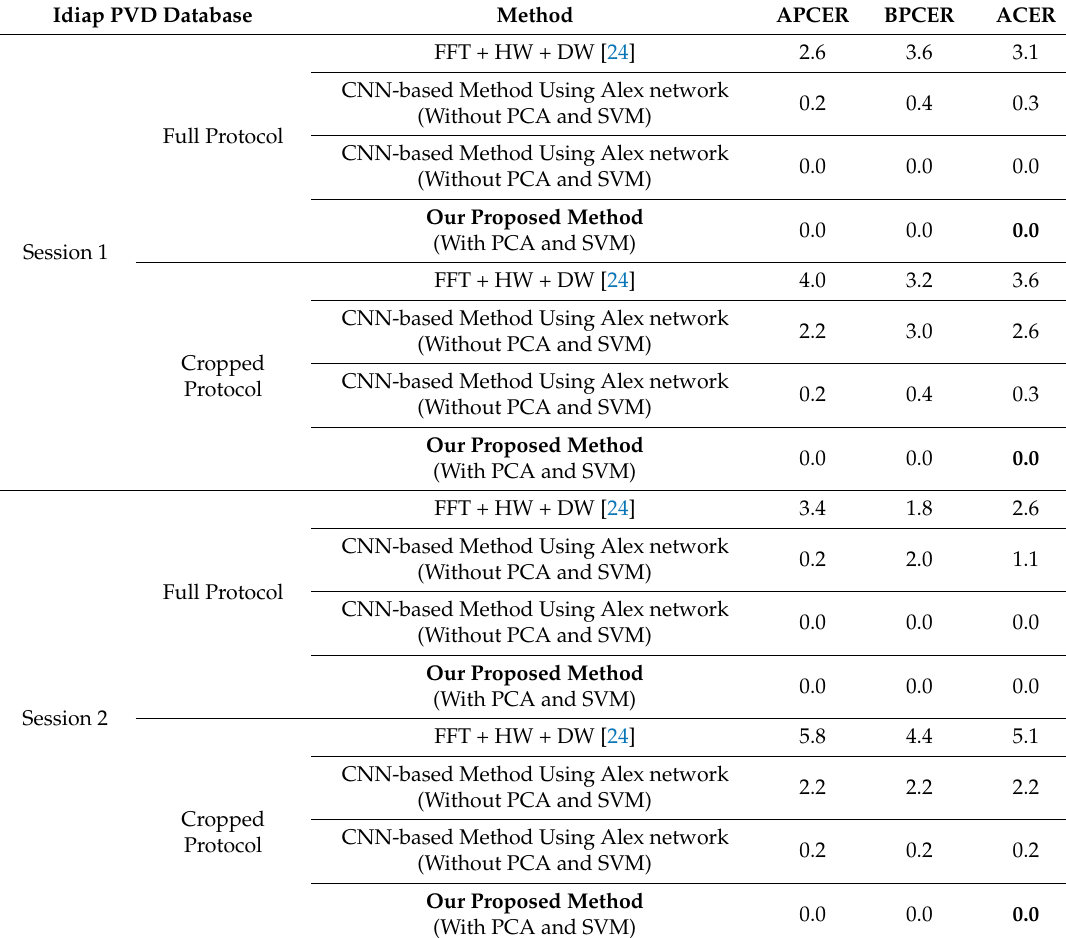
Table 24. Detection errors using Idiap PVD database (unit: